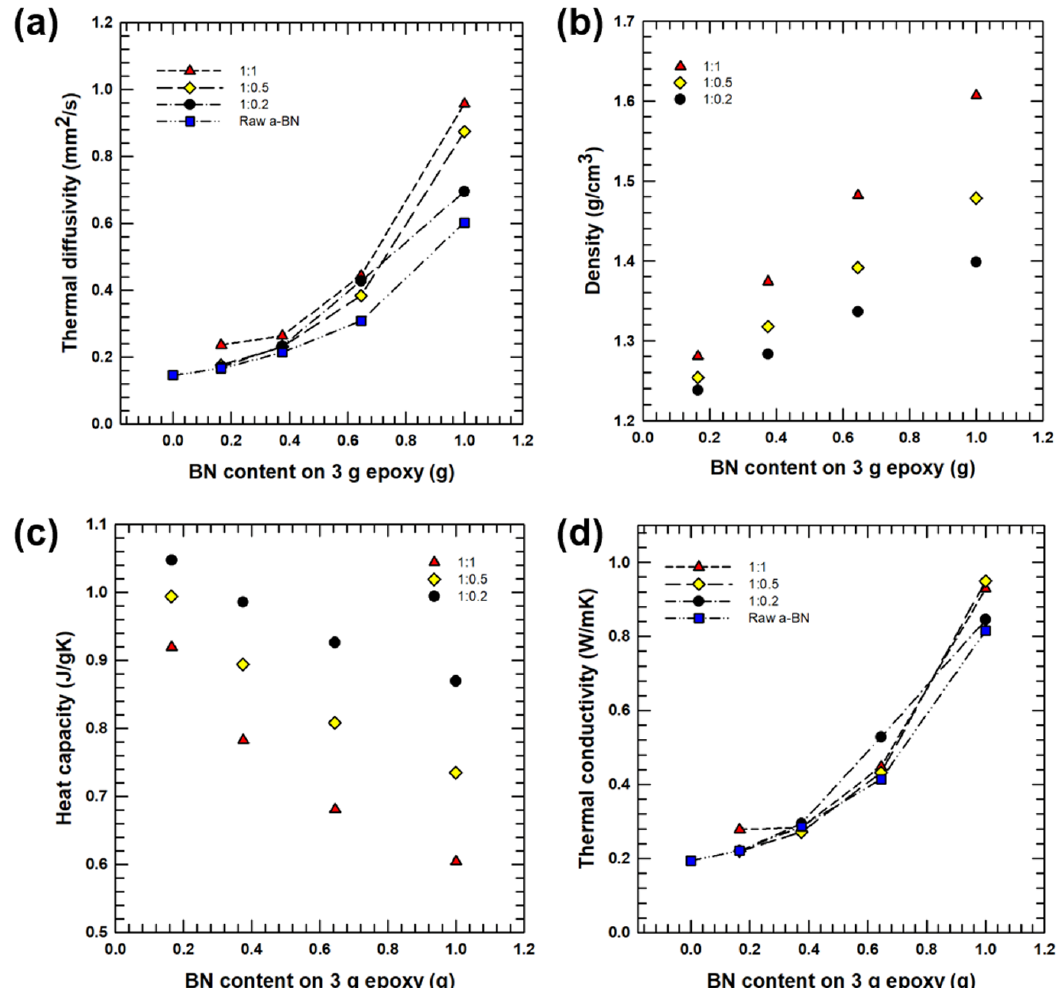
Figure 2. ( a ) Thermal diffusivity, ( d ) thermal conductivity of the composites with raw a-BN, and various ratio of the hybrid fillers. ( b ) Density, and ( c ) specific heat of the composites with different ratios of the hybrid fillers.